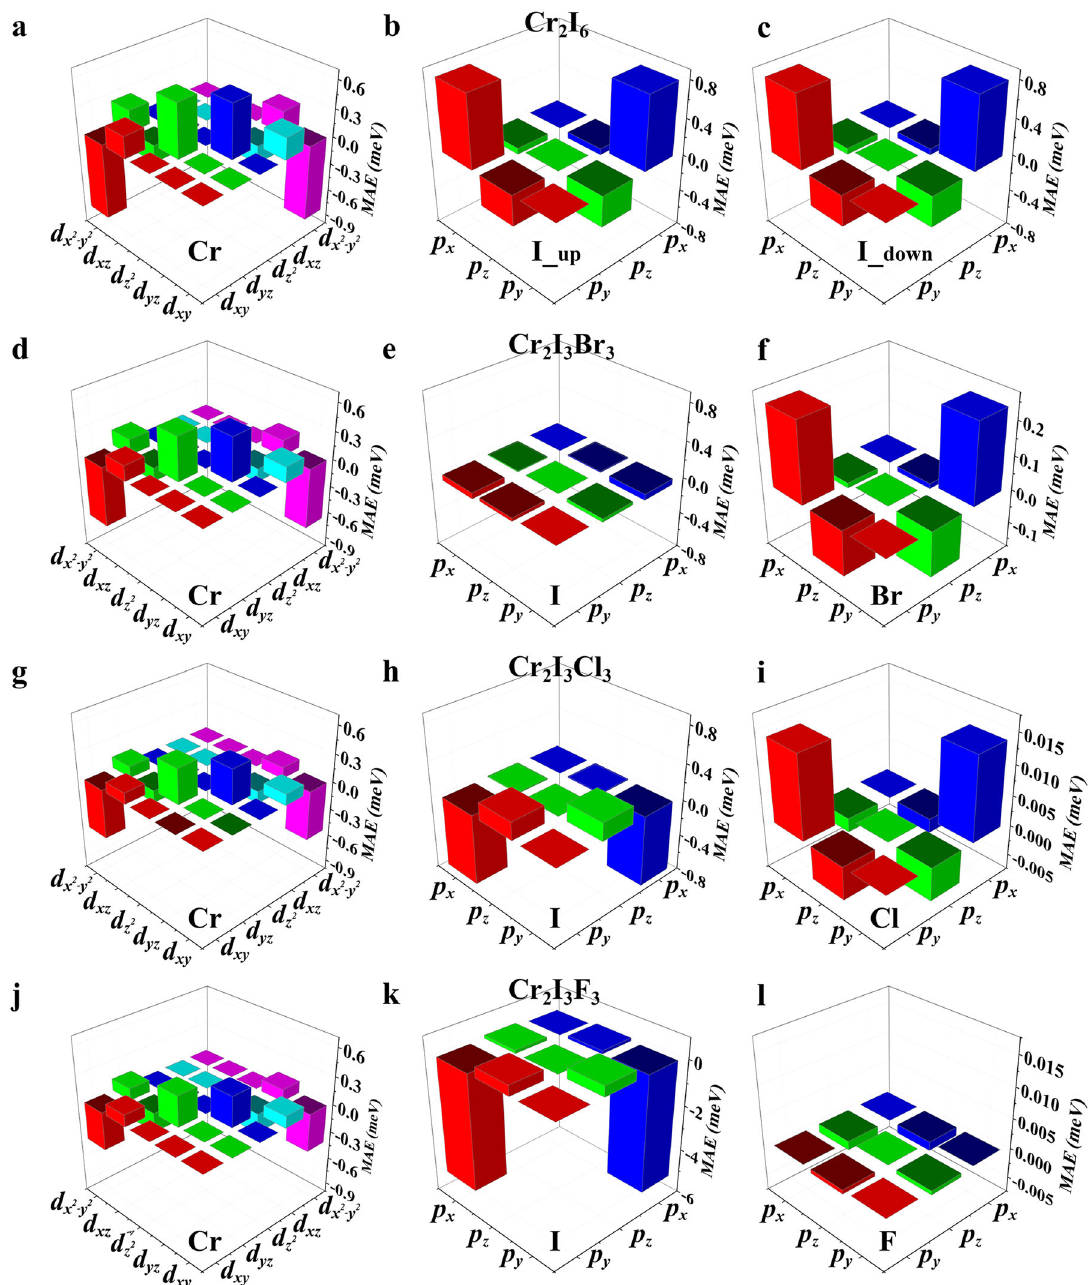
Fig. 5 Orbital-resolved MAE. Orbital-resolved MAE of Cr- d orbitals and halogen- p orbitals (I, Cl, Br, and F) in Cr 2 I 6 and Janus monolayers. Orbitals of Cr 2 I 6 monolayer: a Cr- d orbitals, b up-layer I- p orbitals, c down-layer I- p orbitals; Orbitals of Cr 2 I 3 Br 3 monolayer: d Cr- d orbitals, e I- p orbitals, f Br- p orbitals; Orbitals of Cr 2 I 3 Cl 3 : g Cr- d orbitals, h I- p orbitals, i Cl- p orbitals; Orbitals of Cr 2 I 3 F 3 monolayer: j Cr- d orbitals, k I- p orbitals, l F- p relationship between MAE and EP in Janus Cr 2 I 3 Y 3 systems, which can open a new way to achieve bitunable magnetism/polarity xy -plane (e.g. along z direction) can be triggered by the vertical EP, which originates from vertical inversion symmetry breaking. These facts also indicate that the magnitude of the electric dipole and we demonstrate that the magnetic states can be tuned by moment of 2D Janus Cr 2 I 3 Y 3 can be fi nely tuned by operating spin changing the strength of EP in Janus Cr 2 I 3 Y 3 systems. The strength of perpendicular electric dipole in 2D Janus Cr 2 I 3 Y 3 is mainly derived orientations. Our results show the inherent relationship between magnetism and polarity in the Janus Cr 2 I 3 Cl 3 structures. Fine- from the distance between positive and negative charge centers. The electrostatic potentials in Fig. 4 show that the capability of tuned MAE is one of the pivotal parameters for magnetic capturing electrons is imbalanced on different halogen layers. information storage and modern information data recording and Hence, the magnitude of the electric dipole moment in Cr 2 I 3 Y 3 is processing. It is of great value to explore the quantitative